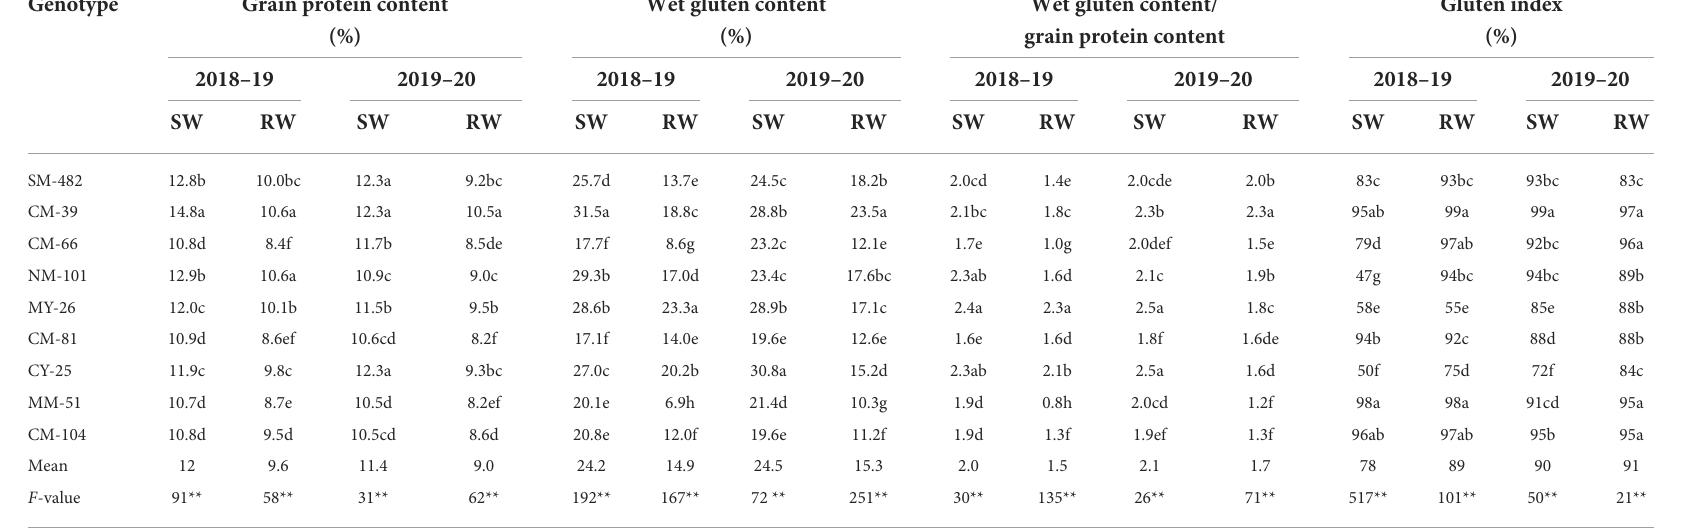
TABLE 4 The grain protein quality-related traits of nine wheat genotypes in two wheat cropping systems and two cropping years. Genotype Grain protein content